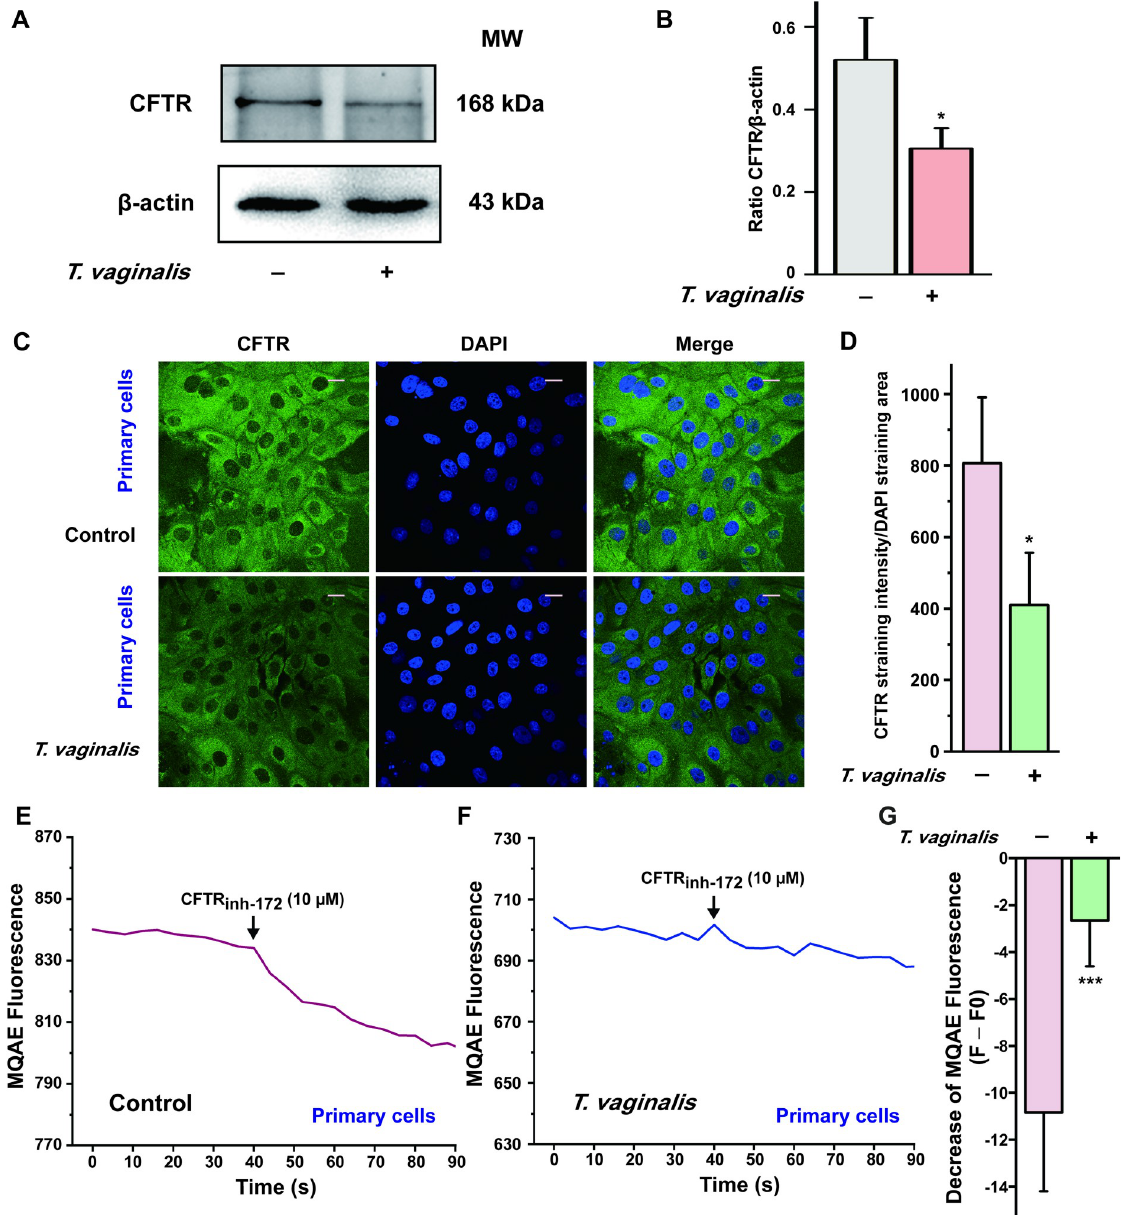
Fig 3. Trichomonas vaginalis infection induced down-regulation of cystic fibrosis transmembrane conductance regulator (CFTR) in the primary cultured rat vaginal epithelial cells. (A) Representative blots showing the expression of CFTR in primary cultured vaginal epithelial cells infected with live 1 × 10 6 T . vaginalis for 3 h, using β -actin as a loading control. MW, molecular weight. (B) Statistical analysis of Western blot (CFTR/ β -actin ratio) showing the effect of T . vaginalis infection on the expression of CFTR. Symbols and bars indicate the mean ± S.D. ( n = 3, � P < 0.05 versus the non-infected group). (C) Immunofluorescence images showing the expression of CFTR in primary cultured rat vaginal epithelial cells, in the absence or presence of 1 × 10 6 T . vaginalis infection, with (D) the corresponding quantification analysis ( n = 3, � P < 0.05 versus the non-infected group). Scale bar = 20 μ m. (E) Representative trace showing the change of MQAE fluorescence elicited by CFTR inh-172 (10 μ M) in primary cultured rat vaginal epithelial cells. (F) Representative trace showing the change of MQAE fluorescence elicited by CFTR inh-172 (10 μ M) after 1 × 10 6 T . vaginalis infection for 3 h. (G) Statistical analysis showing the change of MQAE fluorescence intensity elicited by CFTR inh-172 (10 μ M), with or without T . vaginalis infection. Symbols and bars indicate the mean ± S.D. ( n = 31–42 cells for each group, ��� P < 0.001 versus the non-infected group).